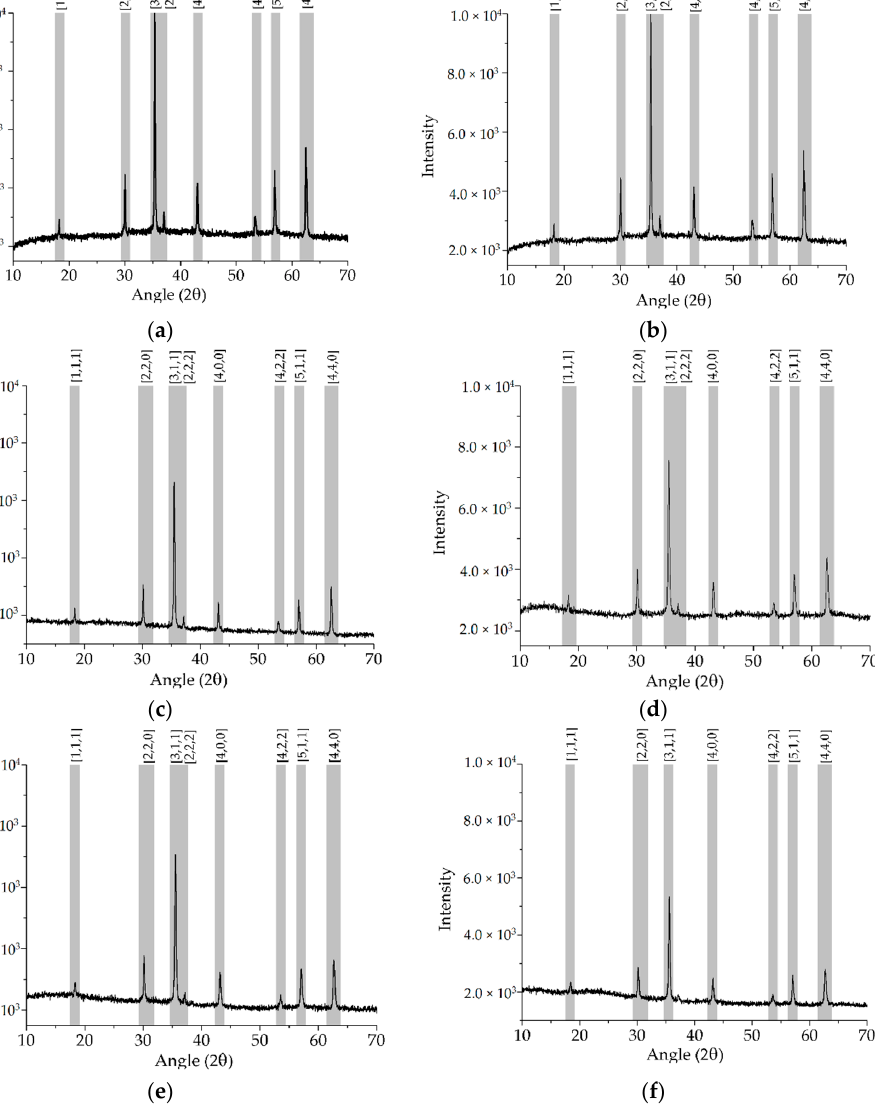
Figure 3. X-ray diffractograms of ( a ) cuboid Fe 3 O 4 nanoparticles, ( b ) cuboid Fe 3 O 4 @SiO 2 nanoparticles, ( c ) cuboid hybrid nanoparticles, ( d ) spheroid Fe 3 O 4 nanoparticles, ( e ) spheroid Fe 3 O 4 @SiO 2 nanoparticles, and ( f ) spheroid hybrid